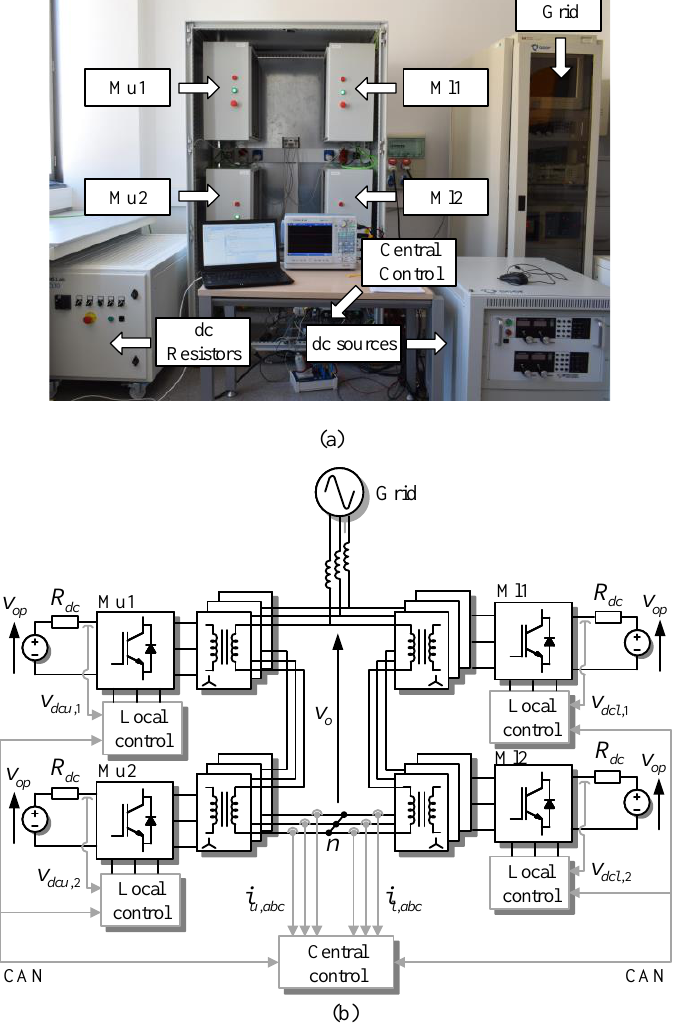
Figure 12. Experimental setup. ( a ) Laboratory prototype, ( b ) electrical circuit